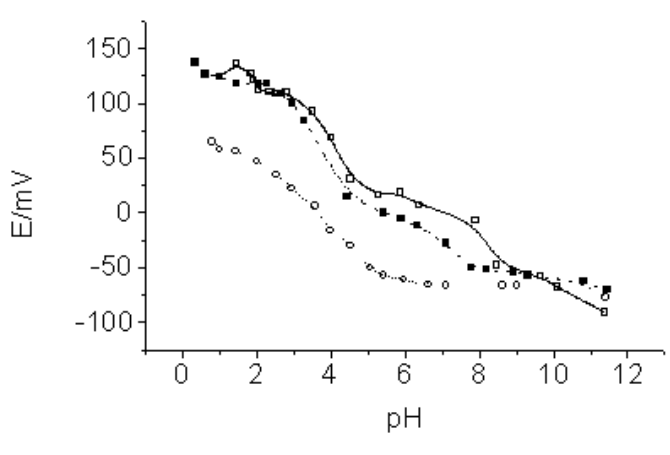
Figure 3. Effect of pH on the potential of the electrode. Electrode A( □ ); Electrode B( ■ ); Electrode C( ○